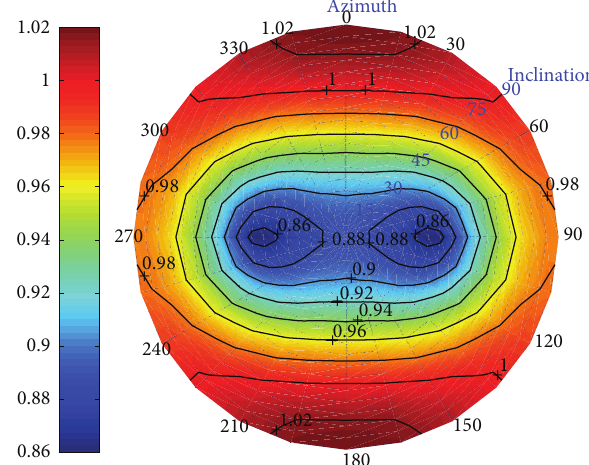
Figure 6: Collapse pressure versus well azimuth in the depleted reservoir with 𝑡 𝑐 = 7